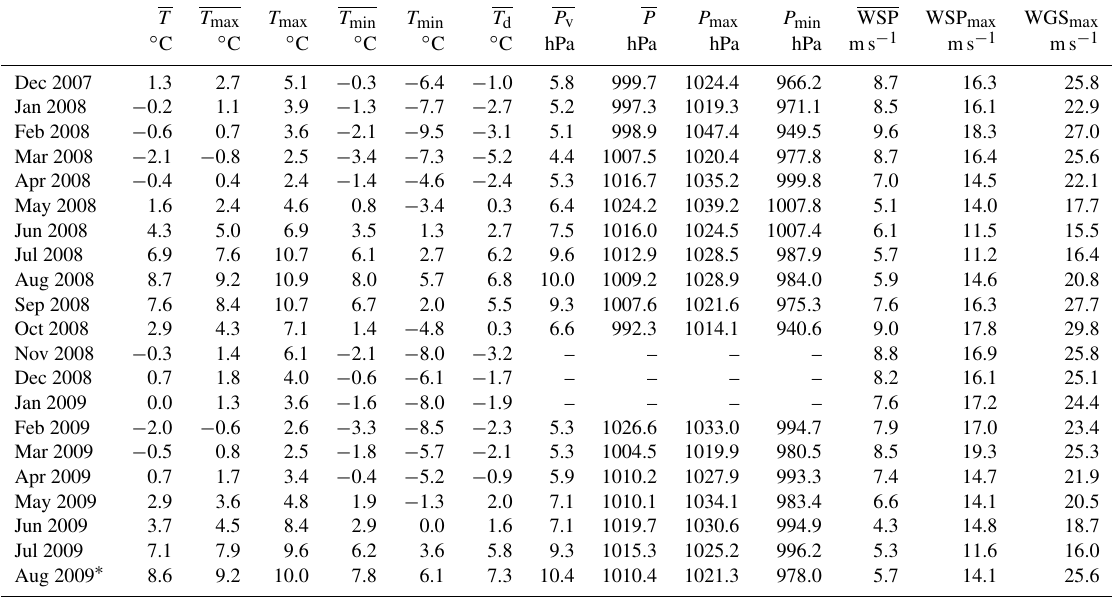
Table 4. Monthly average values, as well as maximum and minimum values where appropriate, for most of the meteorological parameters. The dew point, T d , and the vapour pressure, P v , are calculated using an equation from WMO (2012). Insufficient data is represented with –.